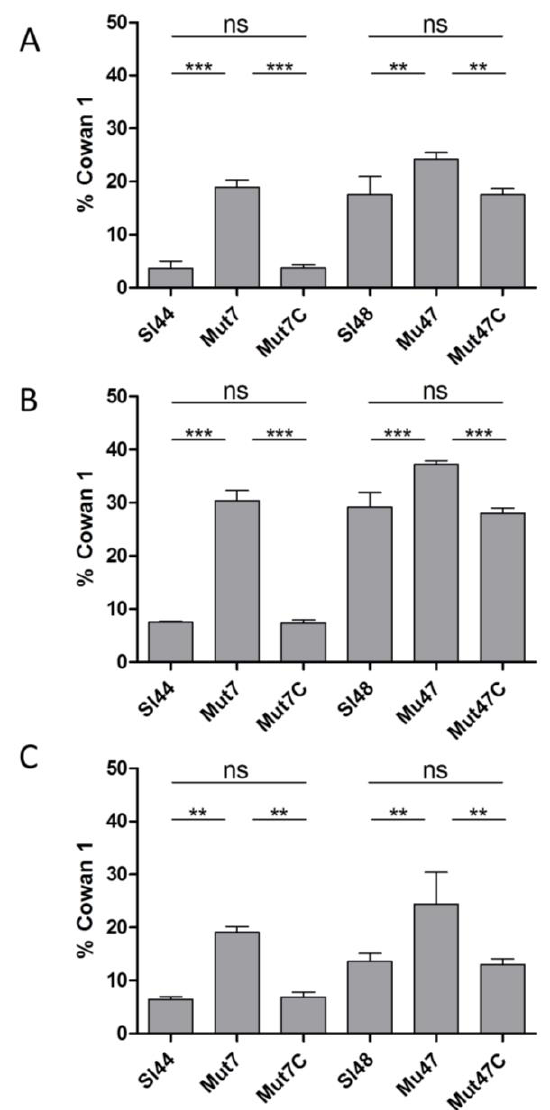
Figure 11. Internalization of FITC-labelled S. lugdunensis wild-type (Sl44 and Sl48), ∆ srtA mutant (Mut7 and Mut47) and complemented mutant (Mut7C and Mut47C) strains by human host cells (( A ): endothelial cell line EA.hy926, ( B ): fetal lung A549 fibroblasts and ( C ): urinary bladder carcinoma cell line 5637 (ATCC HTB-9 ™ )) assessed by flow cytometry and computed in relation to S. aureus Cowan 1. Results are shown as the mean of three independent experiments with the standard deviation (SD).